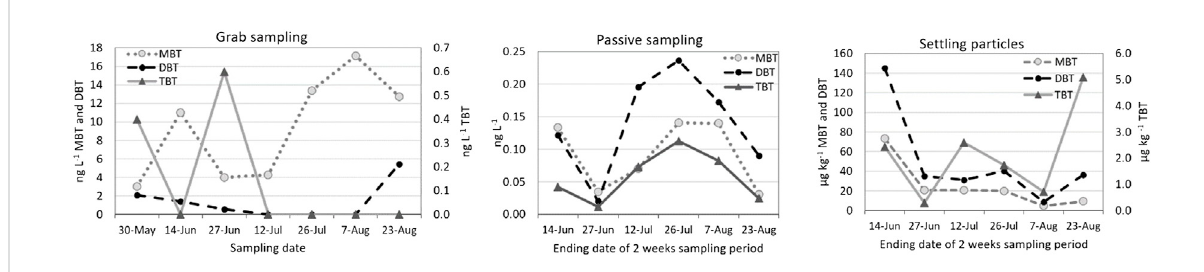
FIGURE 5 ConcentrationofBTCsatsiteoneduring thepipebroke atWWTP. Notice thatthex-axis ofpassivesamplersandsedimentedparticlesdescribe the retrieval date after 2 weeks deployment but in grab sampling the exact sampling